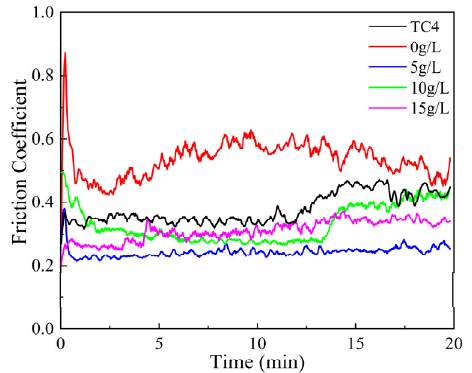
Figure 4. The thickness of MAO coatings with different CuSO 4 concentrations.